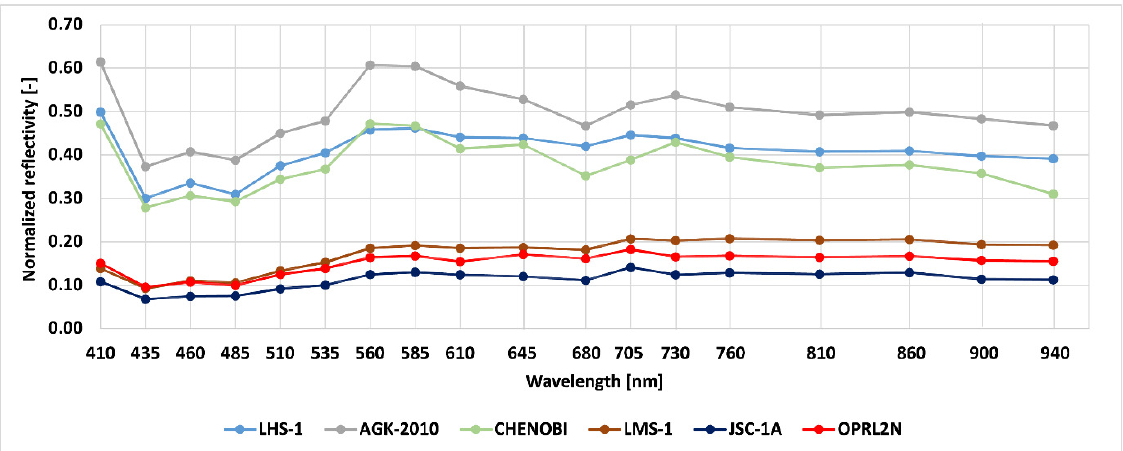
Figure 10. Normalised results of the LSS specimen targets for different wavelengths.